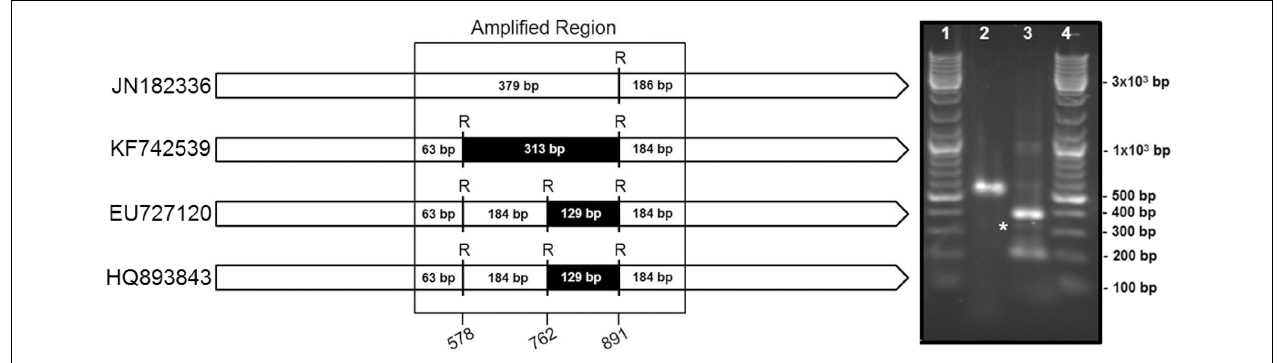
FIGURE 6 | Endosymbionts survey in P. longispinus . Left panel : Restriction maps for the four putatively present 16S rDNA sequences, identified by their accession numbers in GenBank, i.e., “ Ca. Tremblaya princeps” (JN182336) and the sequences of gamma-proteobacterial origin identified by us (KF742539), Duron et al. (2008) (EU727120), and Rosenblueth et al. (2012) (HQ893843). Rsa I restriction sites and expected